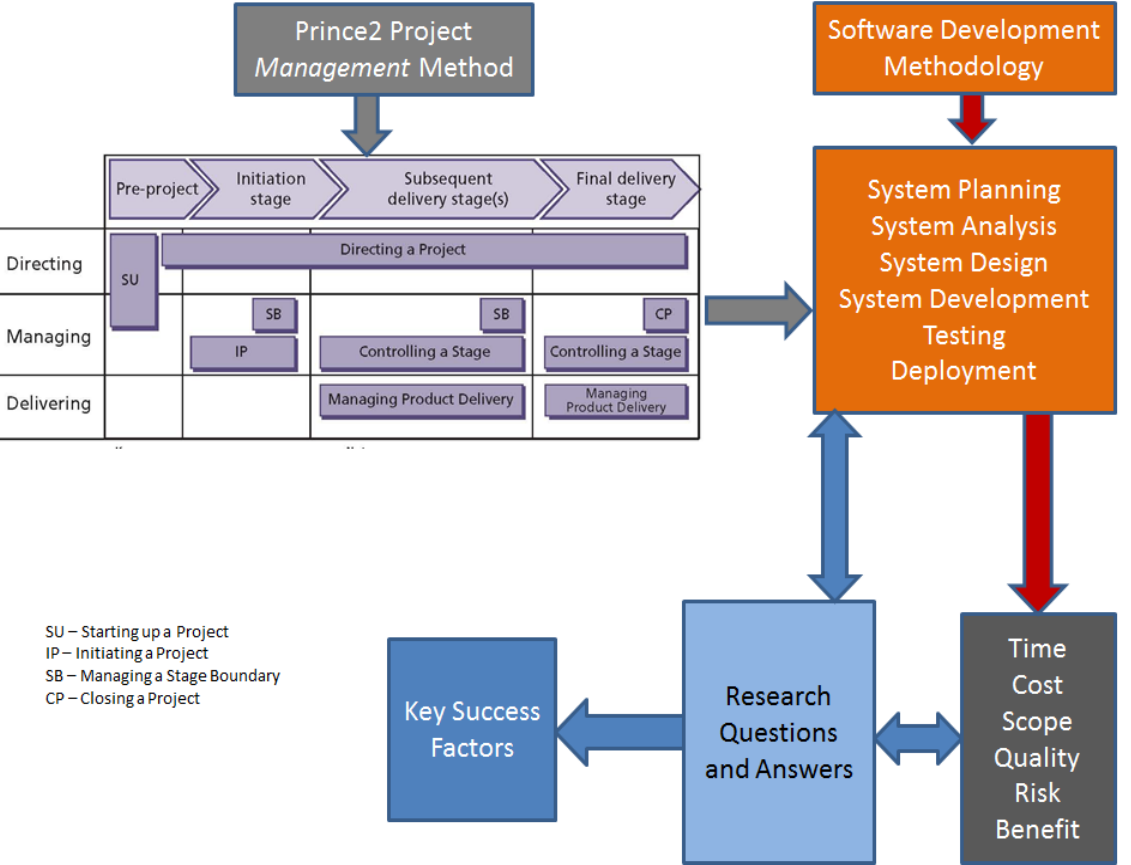
Figure 1: Theoretical Framework of Research